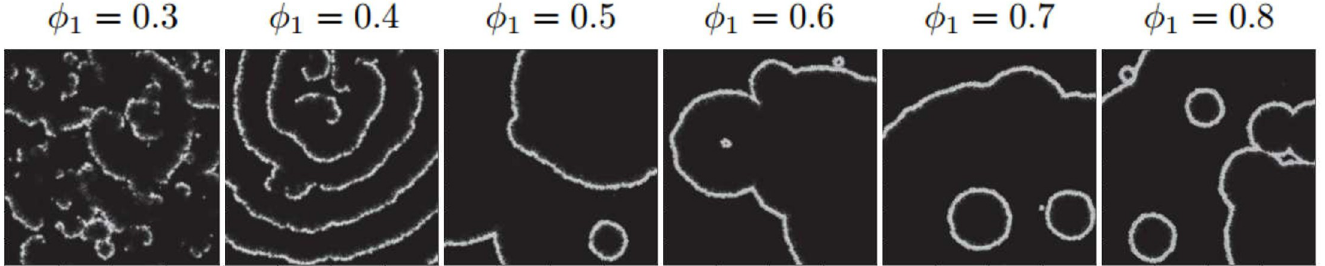
Fig 2. Emergent patterns on different lattices including randomly distributed firing cells with variant ϕ 1 . ϕ 1 is population density of the cells which determines the number density of occupied units on the lattices of size 400 × 400. Here, the cells are exclusively of proactive/cooperative type. All parameters of the model are kept the same for these systems and listed in section S1